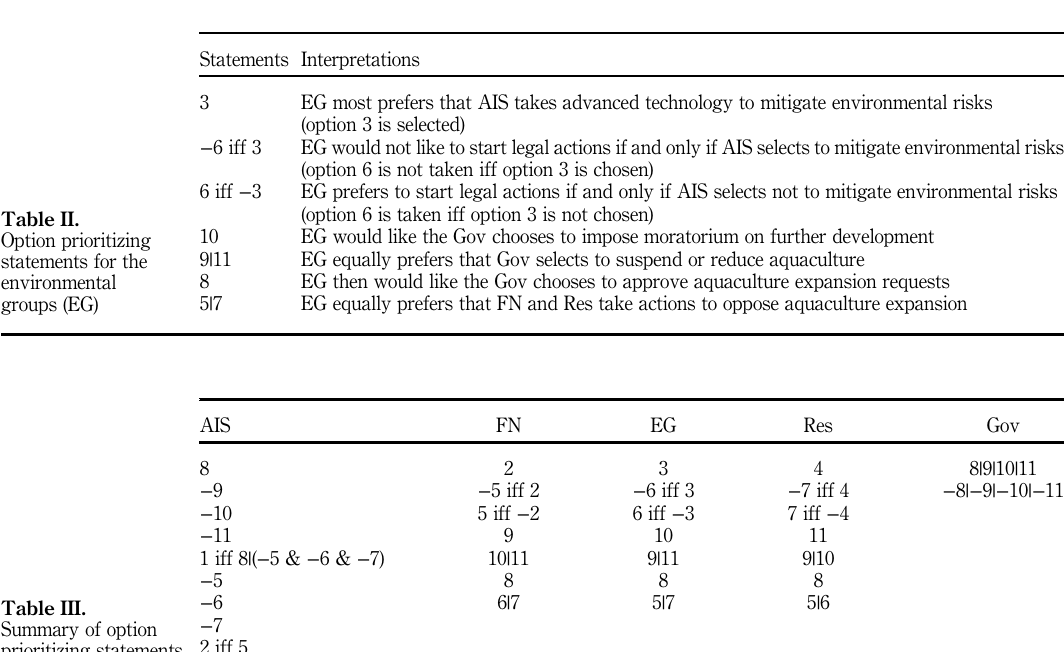
Table III. Summary of option prioritizing statements in